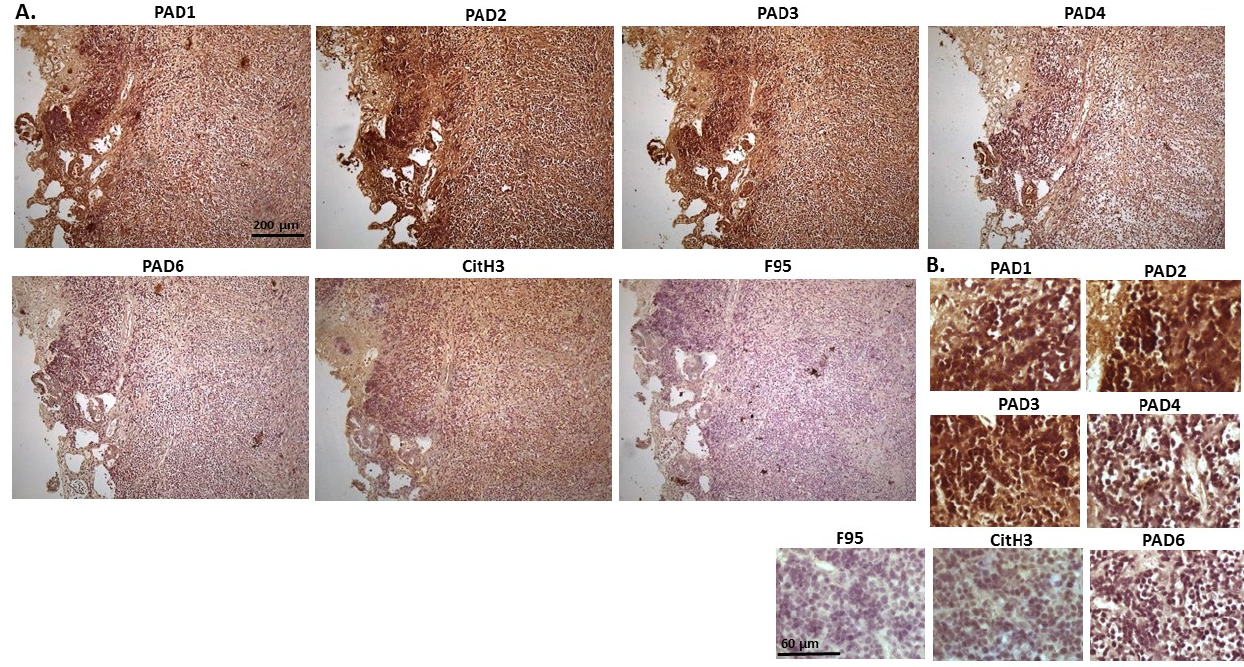
Figure 12. Hamster lymphoma, mesentery/small intestine. Cadaver of a hamster with tumour masses in mesentery. Suspected multicentric lymphoma cause by Hamster Polyomavirus (HaPV). ( A ) Overview images for PAD1, 2, 3, 4, 6, CitH3 and F95 stainings of serial tissue sections; scale bar represents 200 μ m for all images; 10× objective. ( B ) Higher magnification shown for each staining from the images in ( A ); scale bar represents 60 μ m for all images; 40× objective.